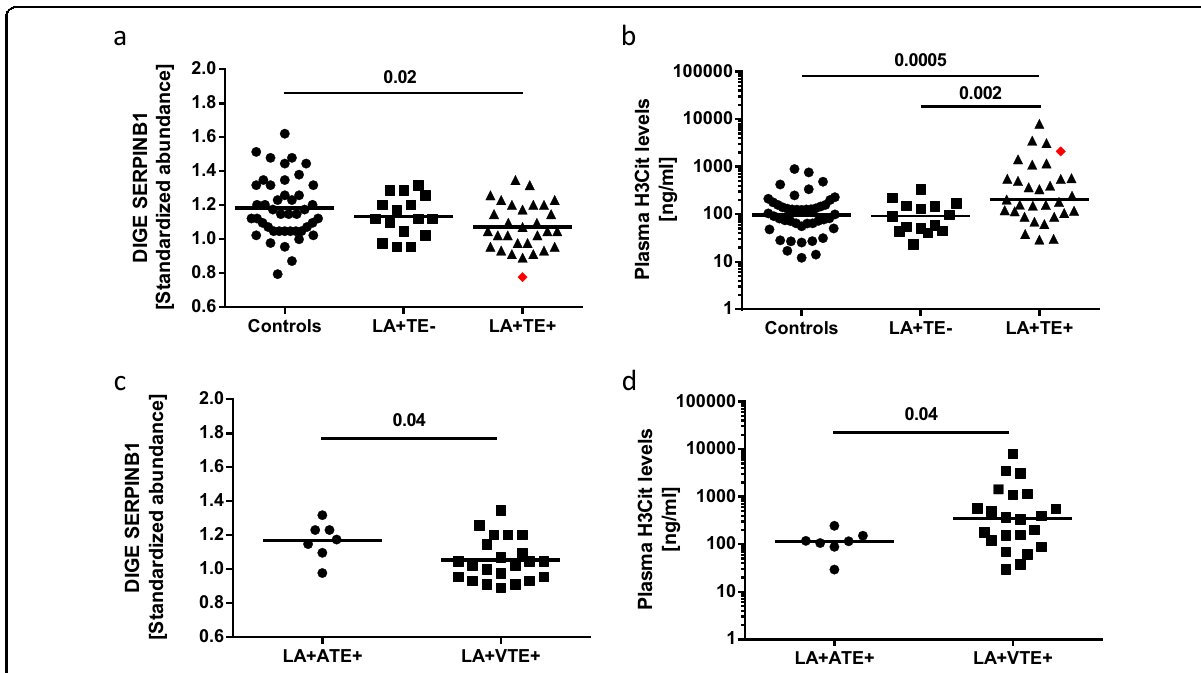
Fig. 3 Analysis of leukocyte elastase inhibitor (SERPINB1) levels in platelets and neutrophil extracellular traps in the plasma of LA-positive patients with or without a history of TE and healthy controls. a Standardized abundance of SERPINB1 in the human platelet proteome showed that LA + TE + patients had signi fi cantly lower protein abundance of SERPINB1 compared to healthy controls ( p = 0.02) and nonsigni fi cantly lower compared to patients without thrombosis ( p = 0.18). b LA + TE + patients had signi fi cantly higher H3Cit levels [ng/ml] compared to healthy controls ( p = 0.0005) or LA + TE − patients ( p = 0.002). c LA-positive patients with a history of VTE had a lower SERPINB1 abundance than LA-positive patients with a history of ATE ( p = 0.04). d H3Cit plasma levels were signi fi cantly increased in LA-positive patients with a history of VTE compared to LA- positive patients with a history of ATE ( p = 0.04). Each dot represents a measurement of a single patient. The patient with CAPS is visualized as a red rhombus. The line between the dots of Fig. 3a, c represents the mean (FDR-corrected t -test and unadjusted Student ’ s t -test) and of Fig. 3b, d the median (Wilcoxon-Mann-Whitney-U-Test). LA lupus anticoagulant, TE thromboembolism, 2D-DIGE two-dimensional differential in-gel electrophoresis, CAPS catastrophic antiphospholipid antibody